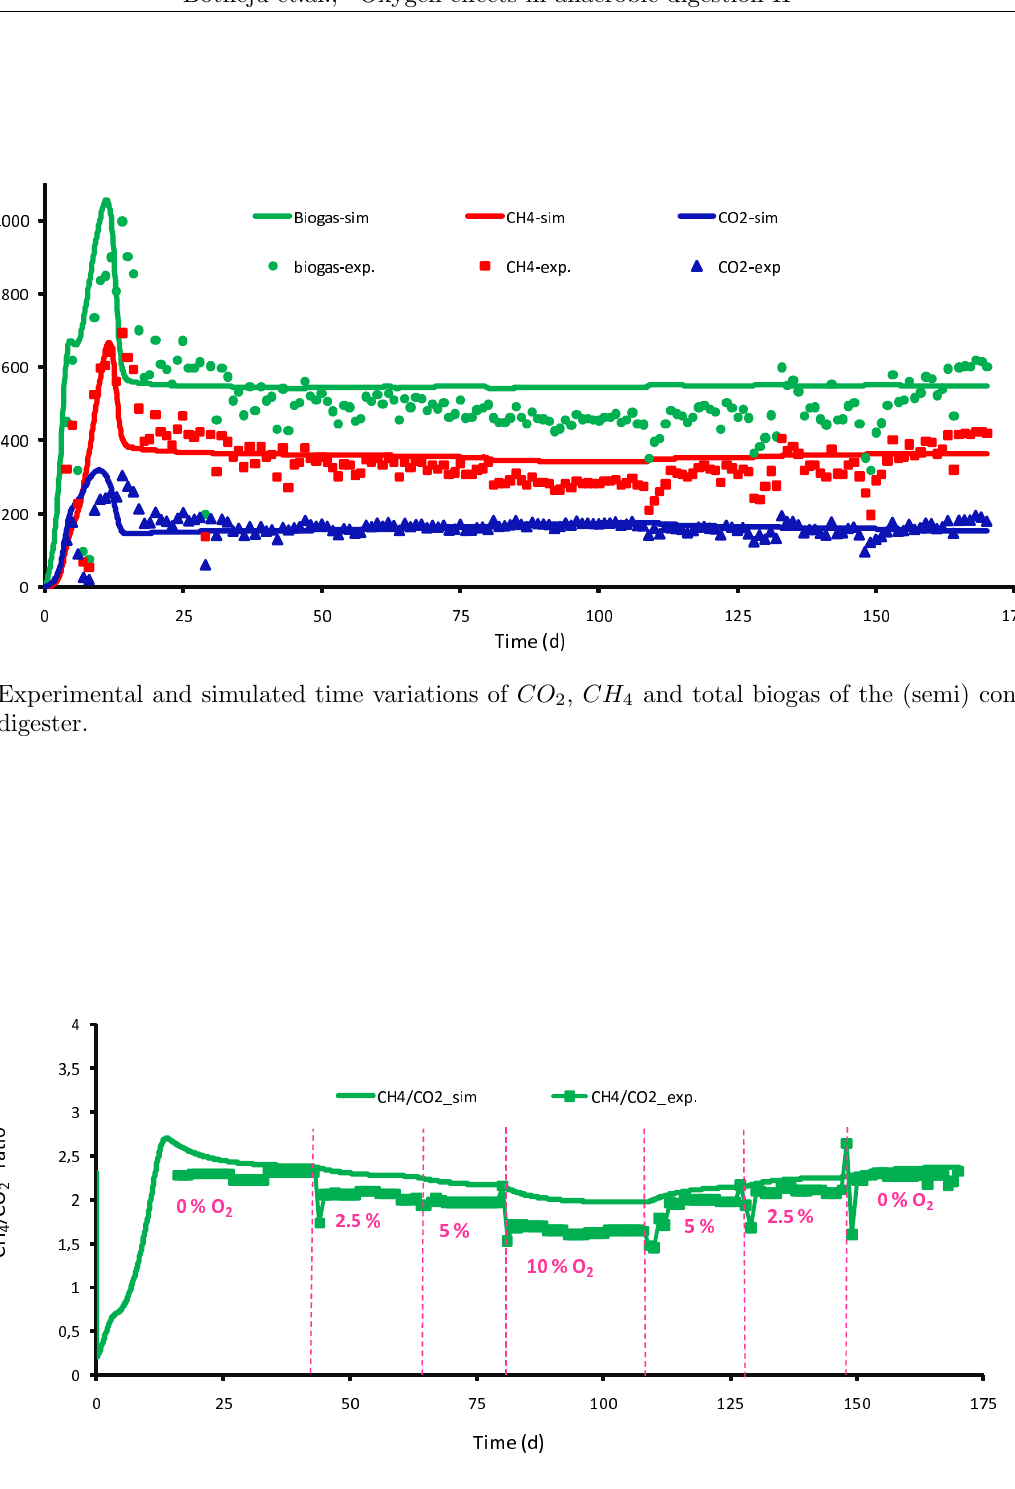
Figure 2: Experimental and simulated time variation of CH 4 /CO 2 ratio under varying oxygen levels of the (semi) continuous